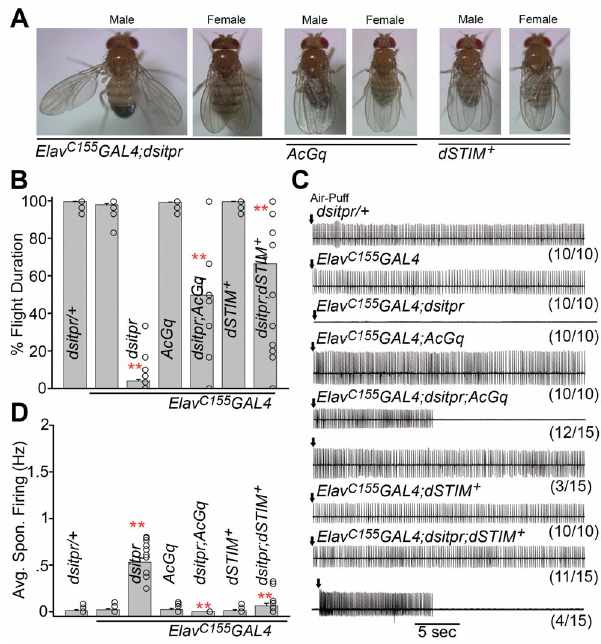
Figure 2. Flight-deficits in flies with pan-neuronal knockdown of the IP 3 R can be rescued by expression of AcGq and dSTIM + . A ) Pan-neuronal expression of either AcGq or dSTIM + suppresses wing posture defects in flies with pan-neuronal knockdown of the IP 3 R ( dsitpr; dicer ). All 100 flies analyzed showed normal wing posture. B ) Air- puff stimulated tethered flight was compromised by pan-neuronal knockdown of the IP 3 R. Significant rescue of the mean percentage flight time was observed by expression of either AcGq or dSTIM + . Results are expressed as mean 6 SEM of the flight time of 30 flies tested individually for flight. Open circles within the bars show the percentage flight times for individual flies. Pan-neuronal knockdown of the IP 3 R was compared with the pan-neuronal GAL4 control; and AcGq and dSTIM + rescues were compared to the itpr knockdown (one-way ANOVA, **P , 0.01). C ) Electrophysiological recordings from the DLMs of air-puff stimulated (arrows) tethered flies are shown. The genotypes are indicated above the traces, and the numbers indicate the number of flies with the observed flight pattern over the number of flies tested. All control flies show rhythmic firing throughout flight. Complete loss of electrical activity was seen in flies with pan-neuronal expression of dsitpr . Expression of either AcGq with dsitpr ( Elav C155 GAL4; dsitpr; AcGq ) or dSTIM + with dsitpr ( Elav C155 GAL4; dsitpr; dSTIM + ) restored electrical firing from the DLMs to varying extents, which is shown as two categories below the indicated genotype. D ) Quantification of spontaneous firing from DLMs of the indicated genotypes. Average spontaneous firing was restored to normal upon expression of AcGq or dSTIM + in pan-neuronal knockdown of IP 3 R. Results are shown as mean 6 SEM. Open circles within the bars are the average spontaneous firing quantified for individual flies. Pan-neuronal knockdown of the IP 3 R ( dsitpr ) was compared to pan-neuronal GAL4 controls and rescues were compared to the knockdown (**P , 0.01, one-way